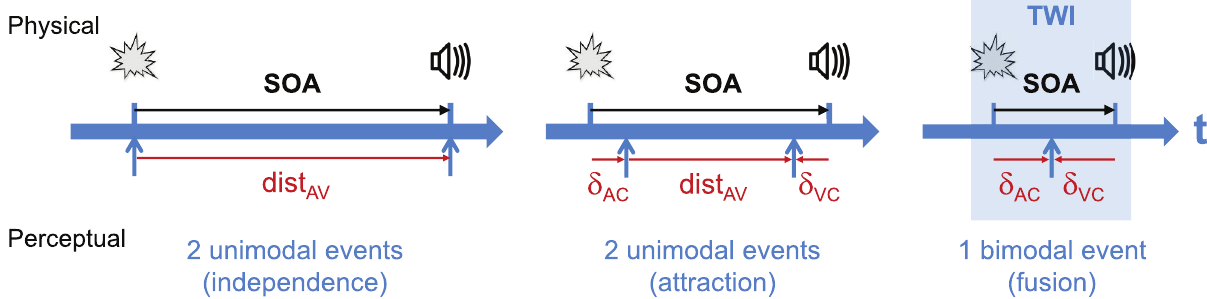
Fig 1. The interaction modes between discrete auditory and visual events. According to the physicaltemporaldistance, the perceptual outcome can be either two unimodal events that are independent (perceivedAV distancedist AV = SOA) or attracted (auditorycapture δ AC or visual capture δ VC not null) for large SOAs; or a fused bimodalevent (dist AV = 0) when closer. The temporalwindowof integration (TWI) can be definedas the maximal range within which visual and auditory events are totally fused (dist AV =